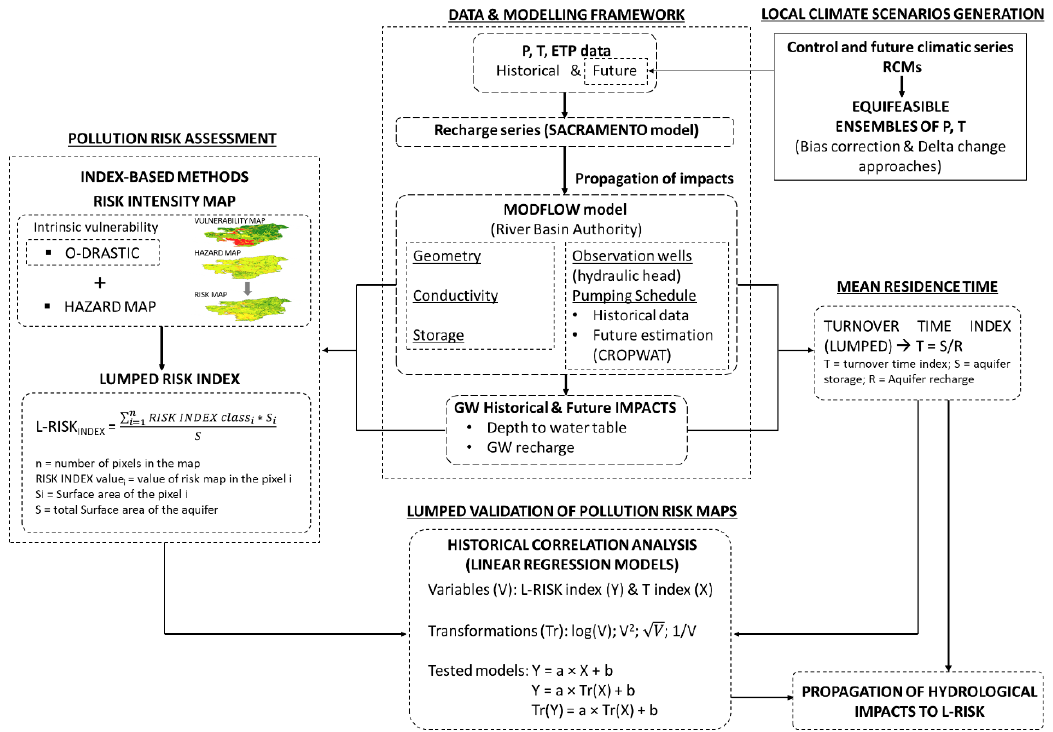
Figure 1. Flowchart of the methodology. L-RISK: lumped risk index; O-DRASTIC: Groundwater vulnerability assessment method based on DRASTIC method; CROPWAT: Computer program for irrigation planning and management.